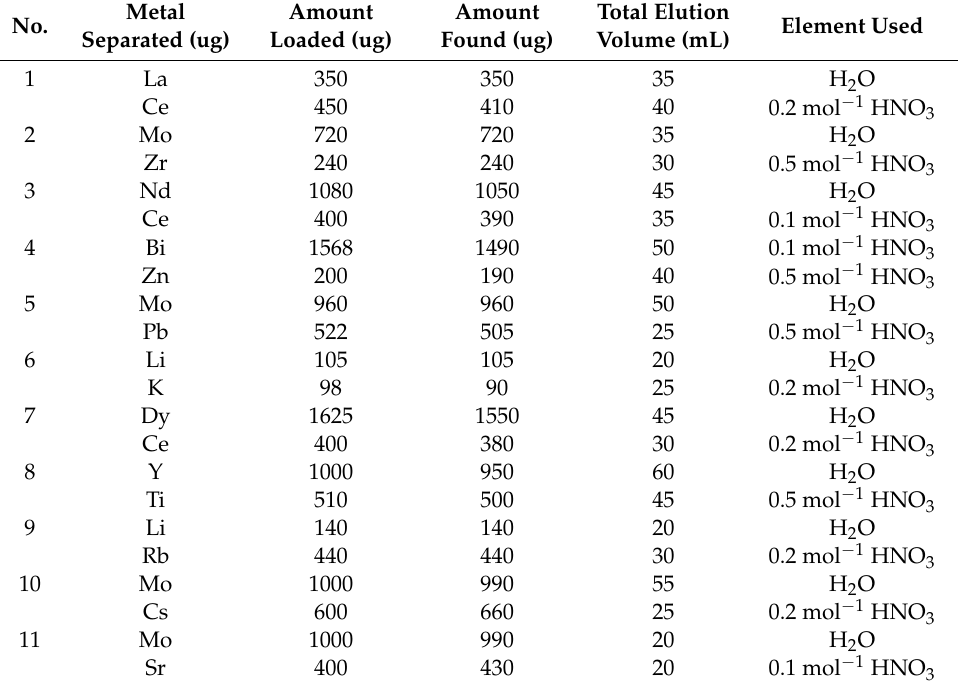
Table 6. Separation of metal ions on titamium (IV) molybdophosphate at room temperature.